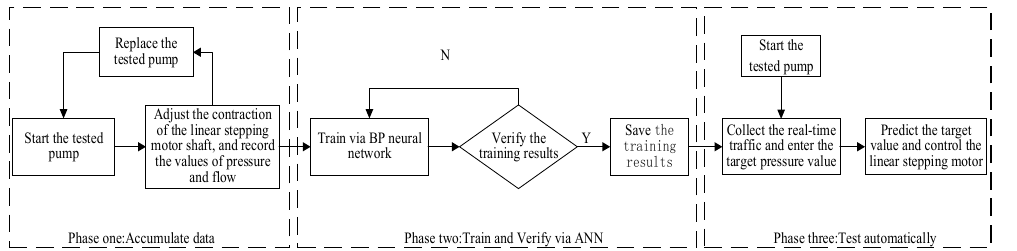
Figure 9. Flowchart for emulsion pump testing based on the artificial neural network algorithm.